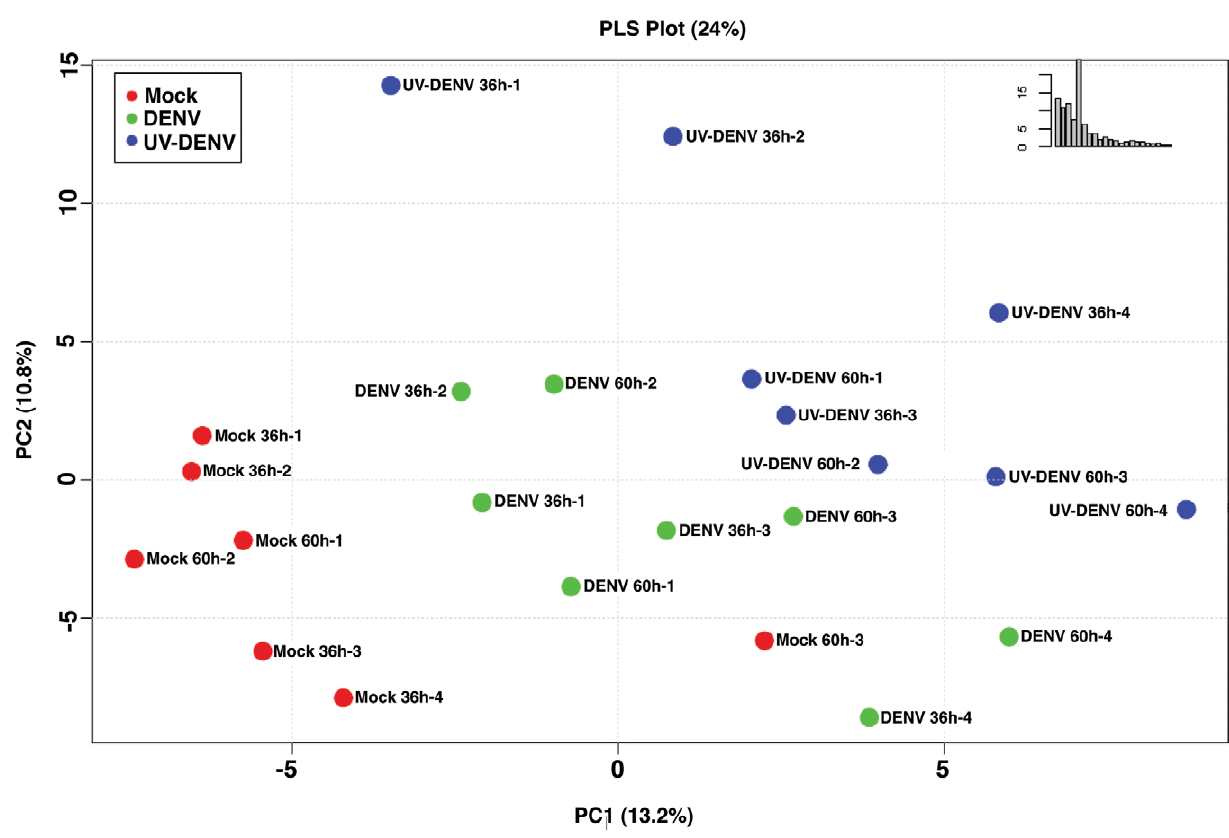
Figure 2. A plot of the principle components analysis scores shows segregation of the global lipid profile between uninfected and DENV-infected mosquito cells. The abundance of lipids in C6/36 cells infected with either DENV (MOI 20) or UV-DENV was measured at 36 and 60 hr post-infection and compared to uninfected controls (mock). Each experiment included 4 independent replicates. A total of 7217 features were compared by principle component analysis (PCA). The plot shows differences that are specific to infectious virus (DENV), a non-replicating virus (DENV-UV) and the mock control.